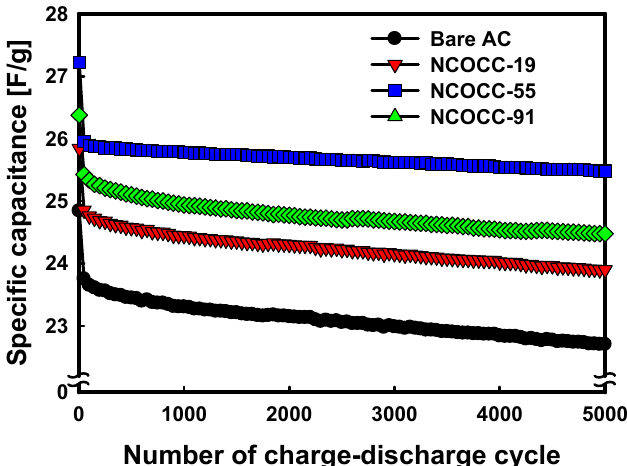
Figure 7. Specific capacitance changed due to charge-discharge during 5,000 cycles of bare AC and NCOCCs.